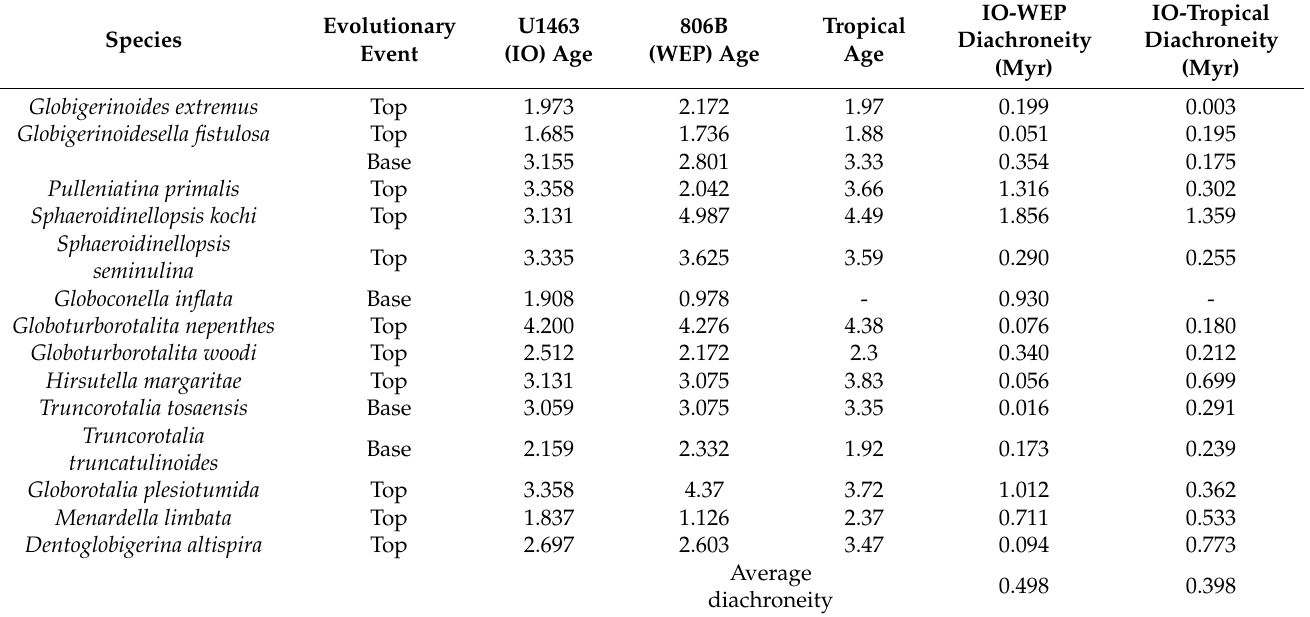
Table 4. Ages of evolutionary events and degree of diachroneity of planktic foraminiferal evolutionary events (latest occurrence of datum subtracted from earliest occurrence of datum) between eastern equatorial Indian Ocean Site U1463 [131] and western equatorial Pacific Hole 806B (IO-WEP), and between Site U1463 and the datum dates from the global tropical planktic foraminiferal zonation [13] (IO-Tropical). IO = Indian Ocean; WEP = western equatorial Pacific. All ages reported in millions of